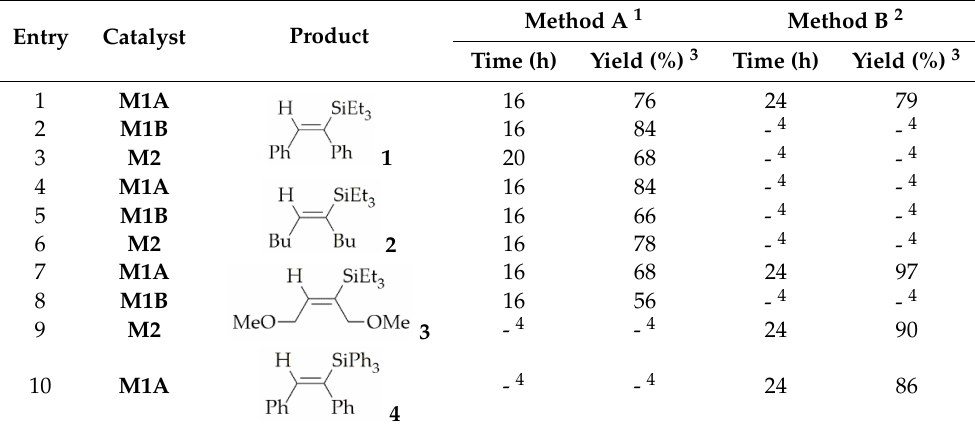
Table 3. Hydrosilylation of symmetric alkynes under catalysis by Rh